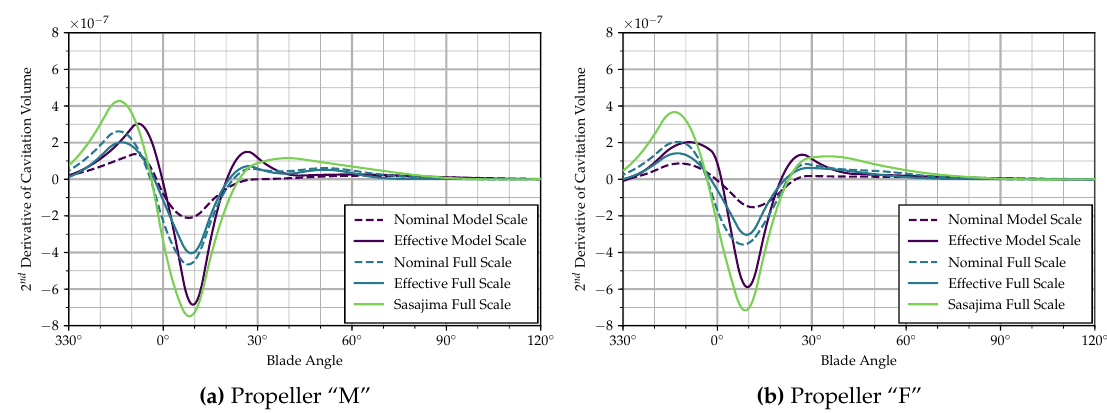
Figure 5. Second derivatives of cavitation